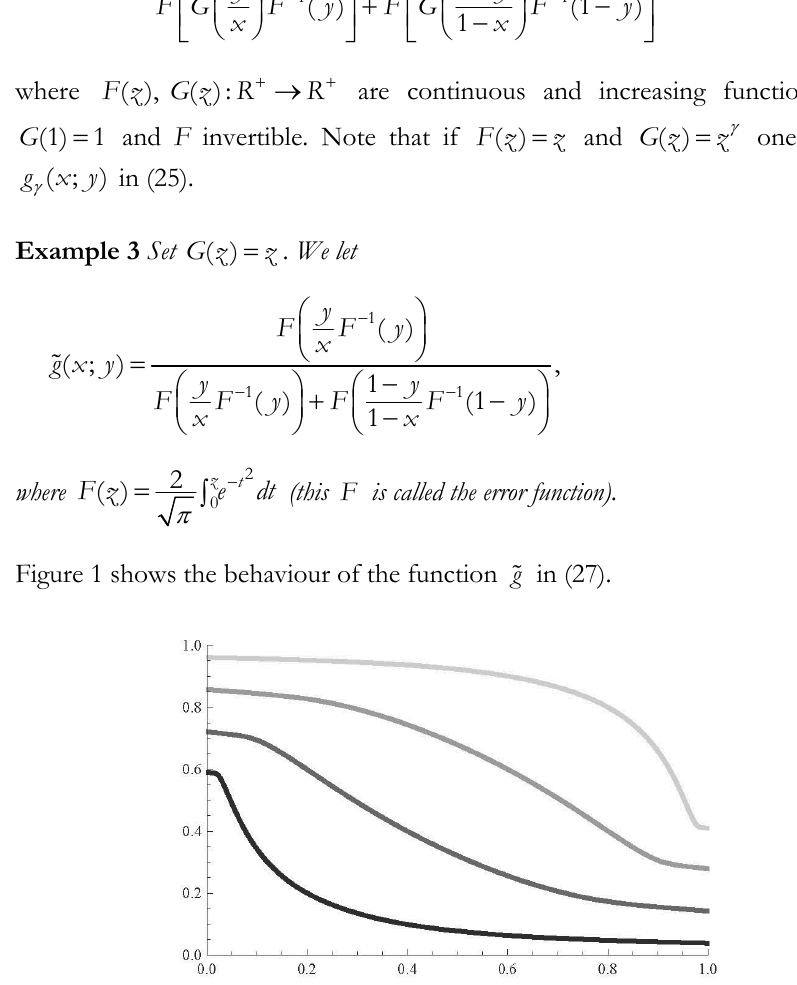
Fig. 1 – Plots of ( ; ) g x y  as x varies in (0,1). The values of y from the bottom curve to the top curve are: 0.2, 0.4, 0.6 and 0.8,